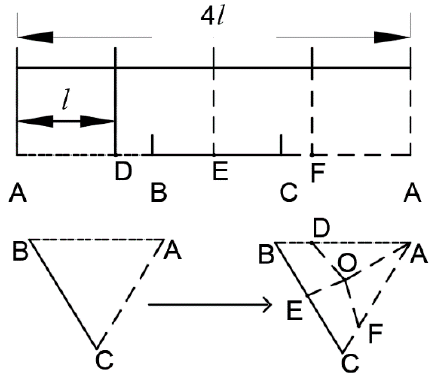
Figure 5. Steps of dividing a triangle into several polygons of equal area; different line types are used to distinguish different sides.